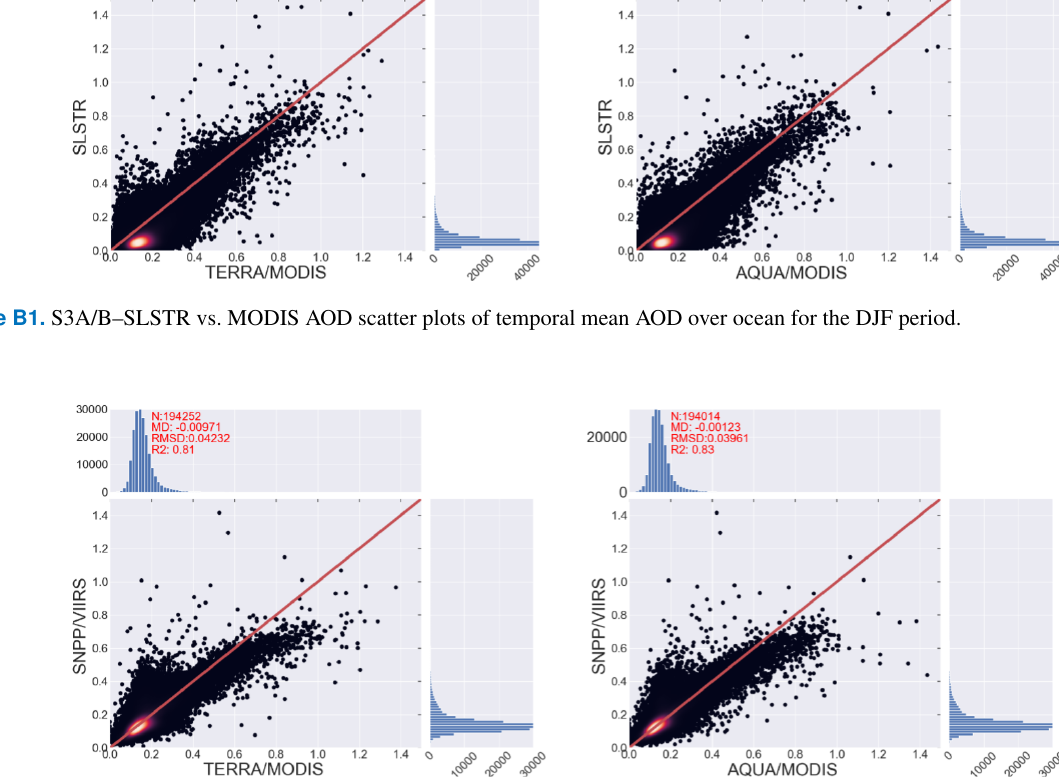
Figure B2. SNPP/VIIRS vs. MODIS AOD scatter plots of temporal mean AOD over ocean for the DJF period.